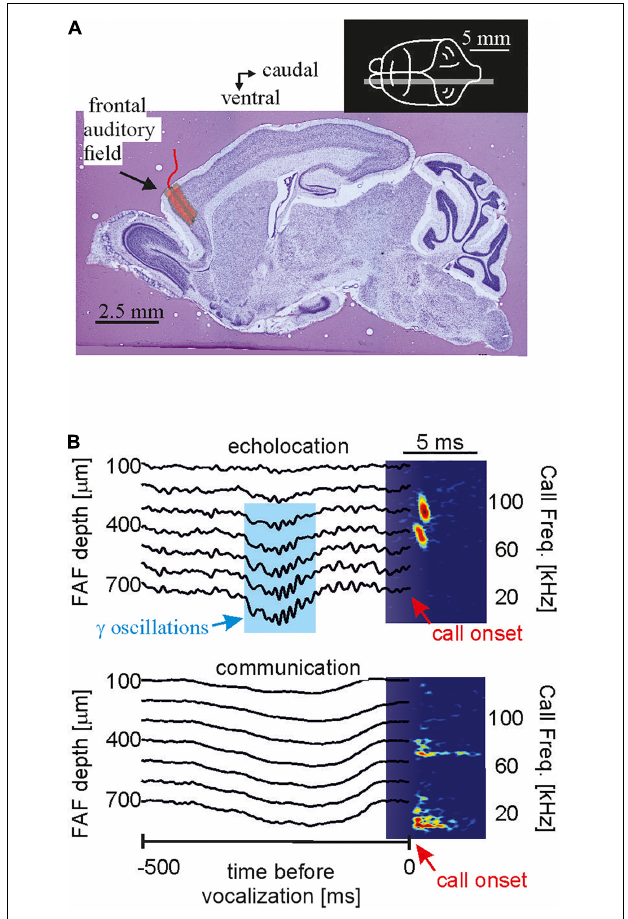
FIGURE 9 | In the bat frontal cortex, gamma oscillations exclusively occur before echolocation but not communication emission. (A) Location of the frontal auditory field in a sagittal brain section of the bat Carollia perspicillata. (B) Neural activity across lamina of the frontal cortex before the production of one echolocation ( upper ) and one communication call ( lower ). Call spectrograms are given as colormaps. Data from Weineck et al.